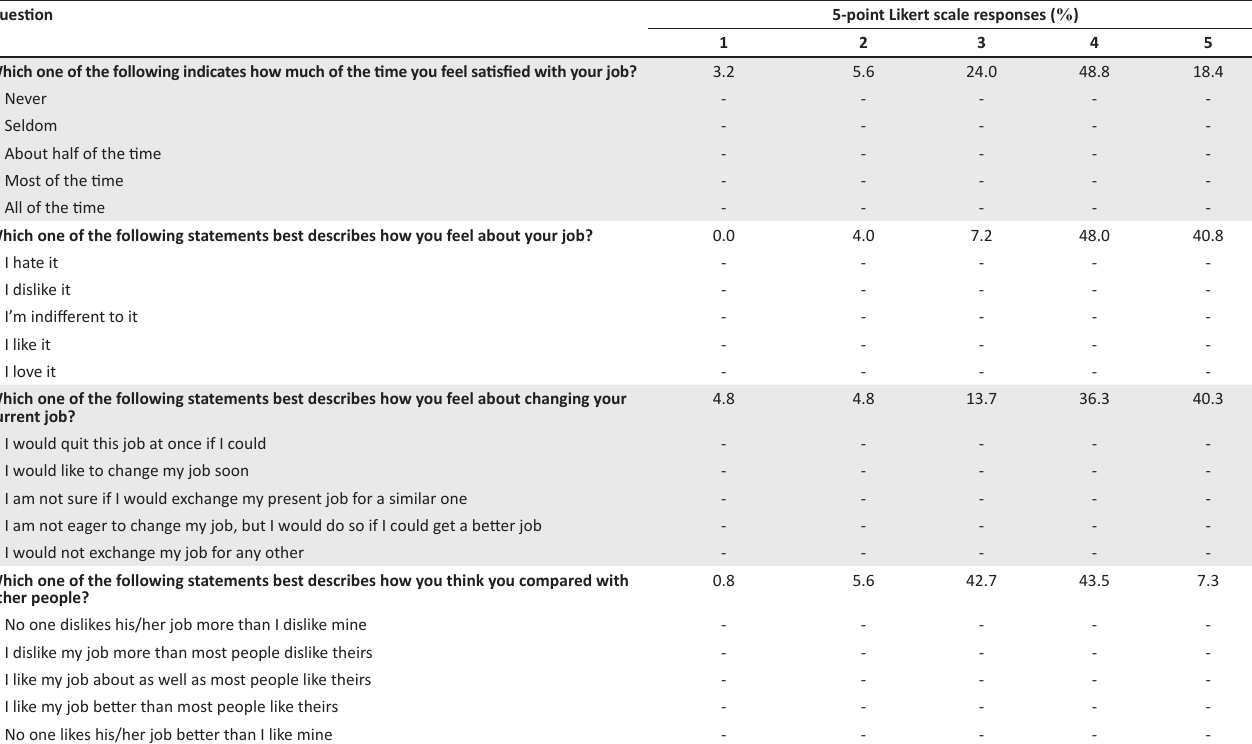
FIGURE 1-A1: Frequency of responses to the Copenhagen Burnout Inventory ( n = TABLE 1-A1: Frequency of responses to the job satisfaction questionnaire ( n = 127).